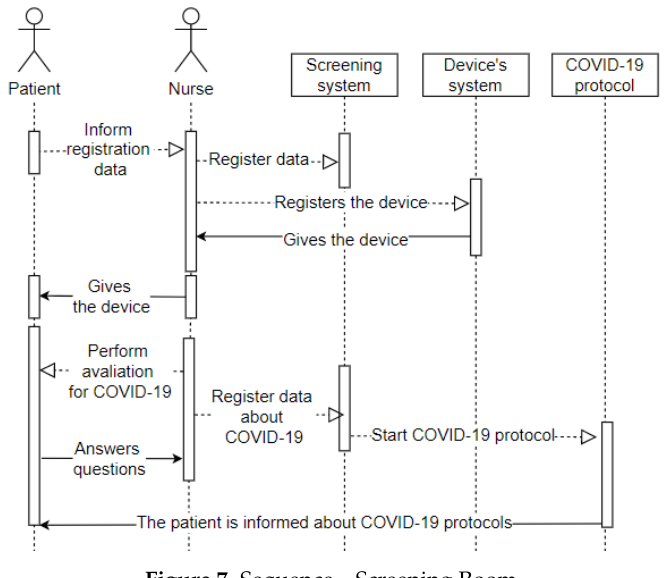
Figure 7. Sequence—Screening Room.